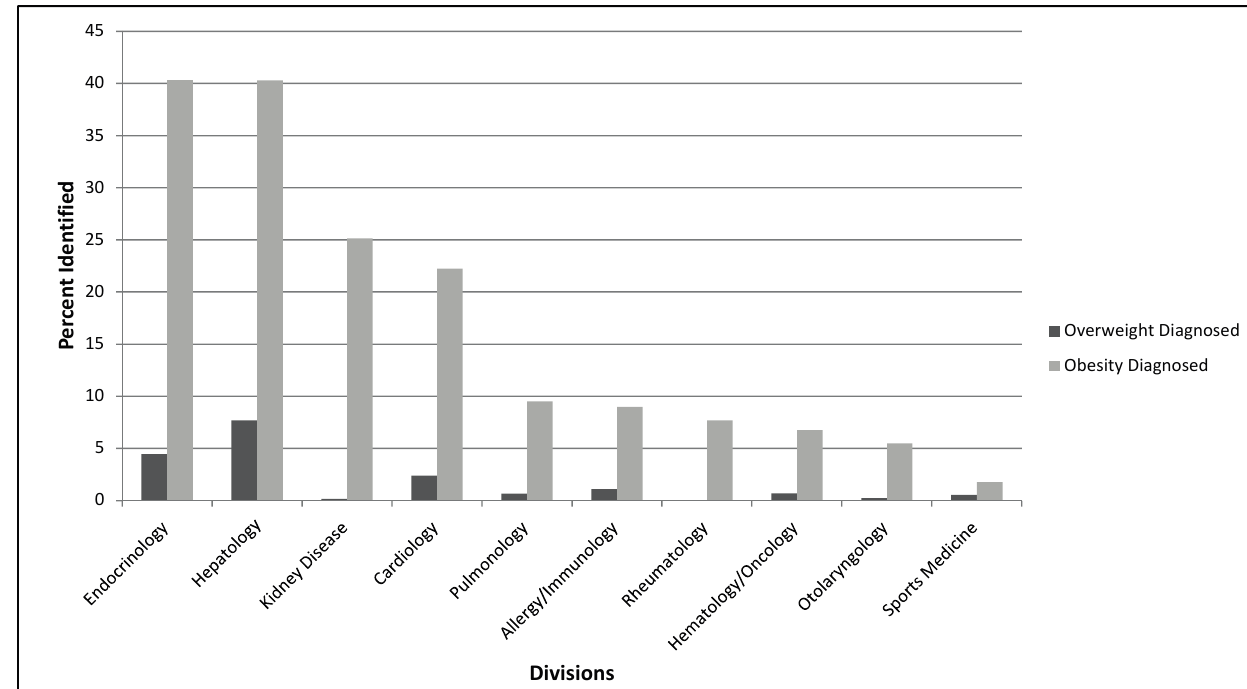
Figure 2. ICD-9 Code Identification of Overweight and Obesity by Subspecialty